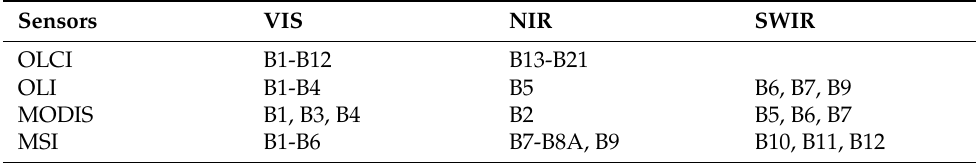
Table 3. Band division by wavelength range of satellite sensors used in the study. Sensors VIS NIR SWIR OLCI B1-B12 B13-B21 OLI B1-B4 B5 B6, B7, B9 MODIS B1, B3, B4